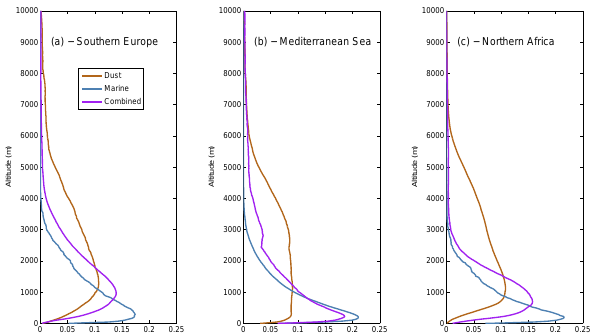
Fig. 11. Mean aerosol type vertical profile from CALIOP (2006-2010) over Southern Europe (left, region 8+9), the Mediterranean sea (middle, region 5+6) and Northern Africa (right, region 1+2).